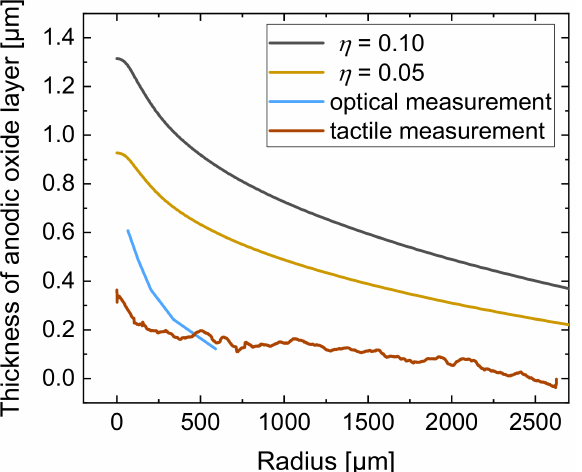
Figure 13. Comparison of the calculated anodic oxide thickness at η = 0.10 (black line) and η = 0.05 (yellow line) with the anodic oxide thickness from optical (blue line) and tactile (brown line) measurements as a function of the